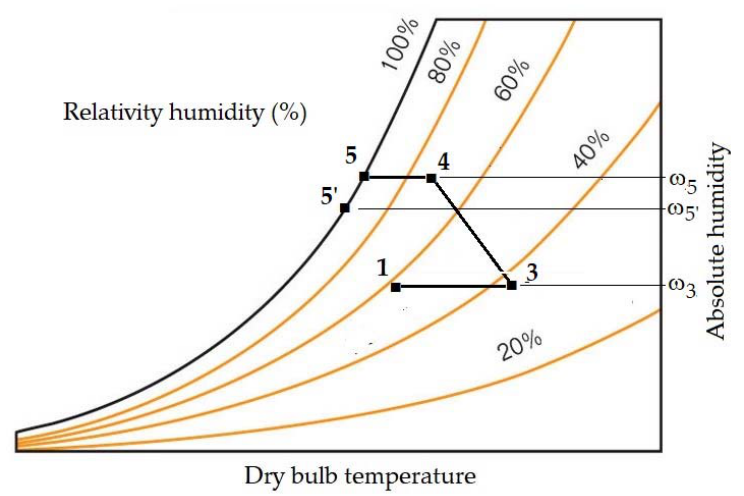
Figure 3. Sketch of a psychrometric chart showing the absolute humidity of the points corresponding to those illustrated in Figure 1.